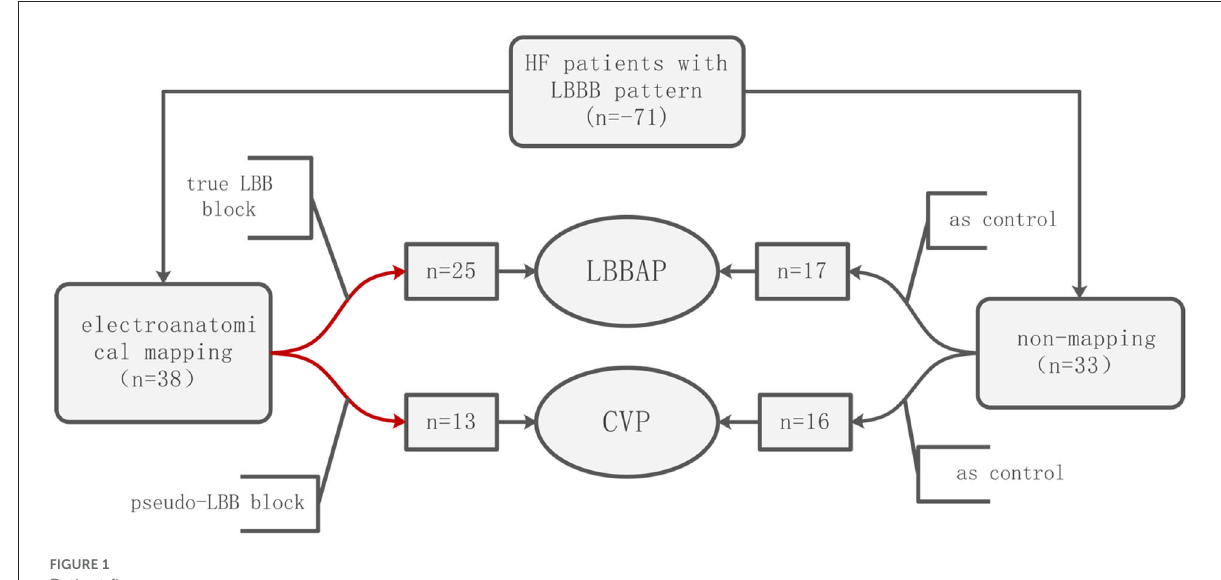
FIGURE1 Patient